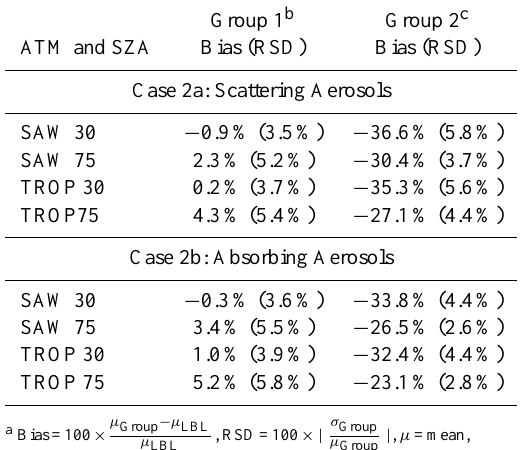
Table 3. Case 1: Summary of Statistics for the Rayleigh Atmosphere a , b , c